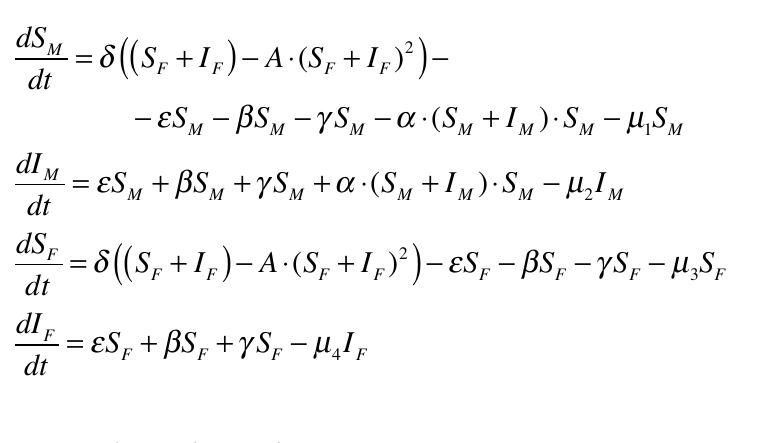
Figure 2. The system of differential equations derived from the diagram in Figure